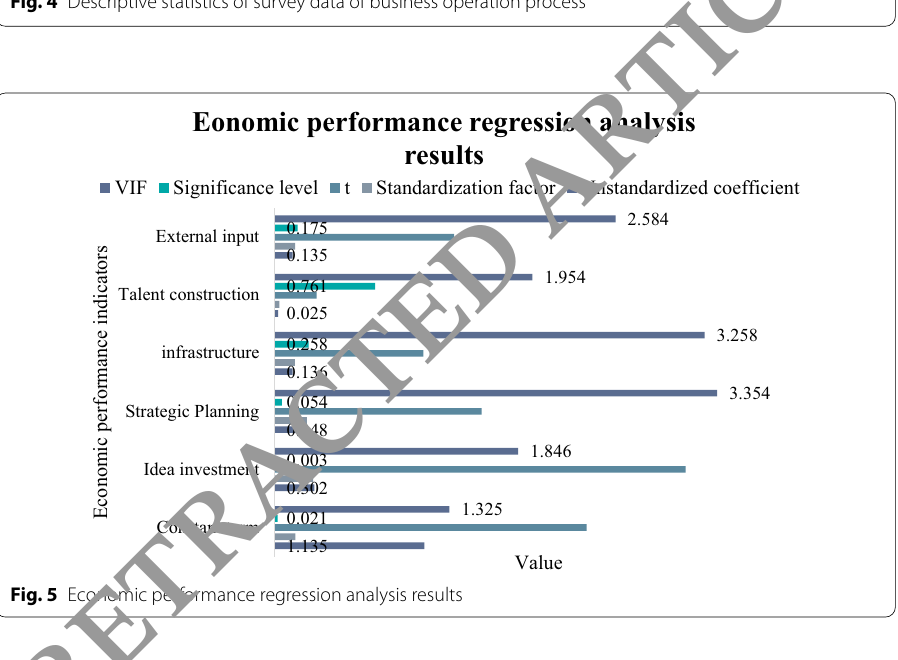
Fig. 5 Economic performance regression analysis